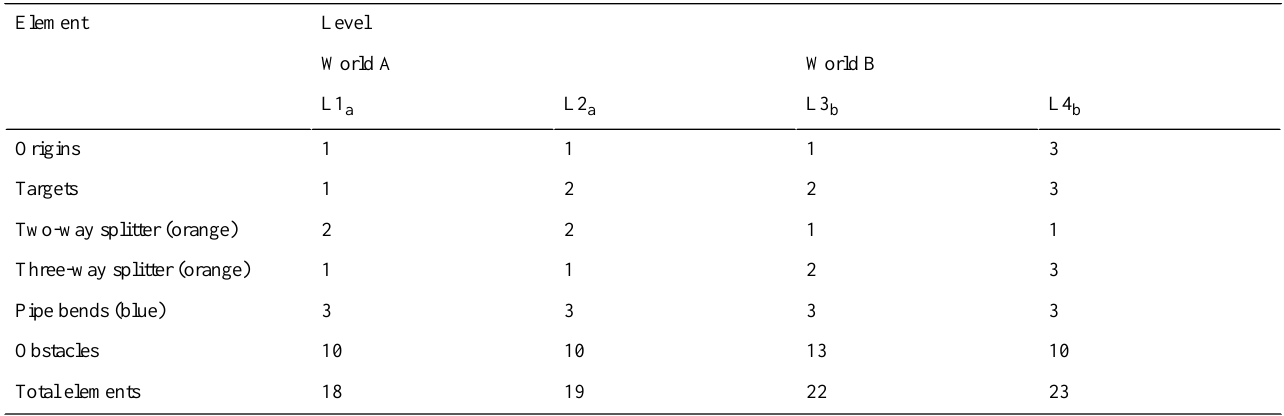
Table 1. Number of game elements in the selected